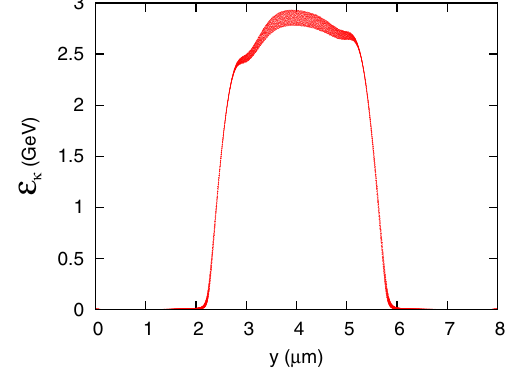
FIG. 6. The final kinetic energy distribution of carbon ions versus the transversal position y .